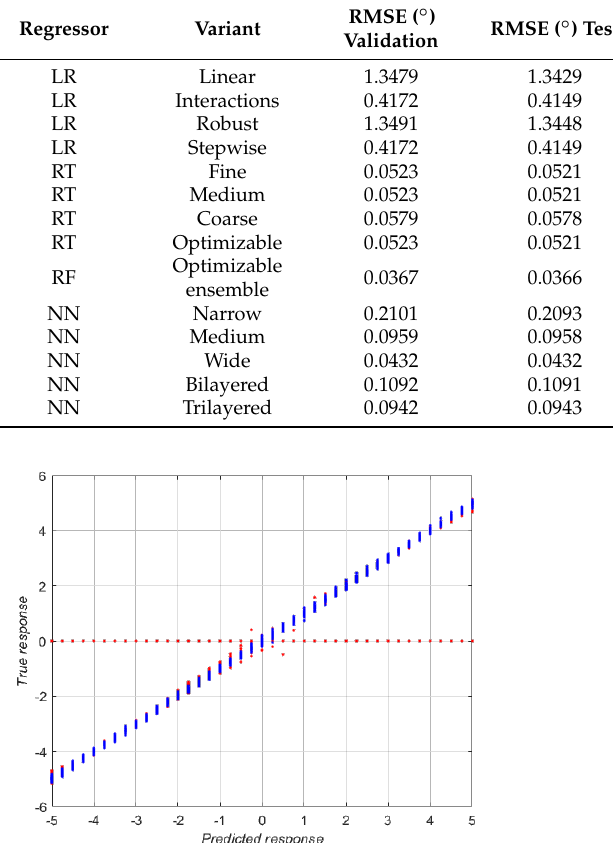
Table 4. Results of filtering the planes used for calibration with regressors of Table 3.